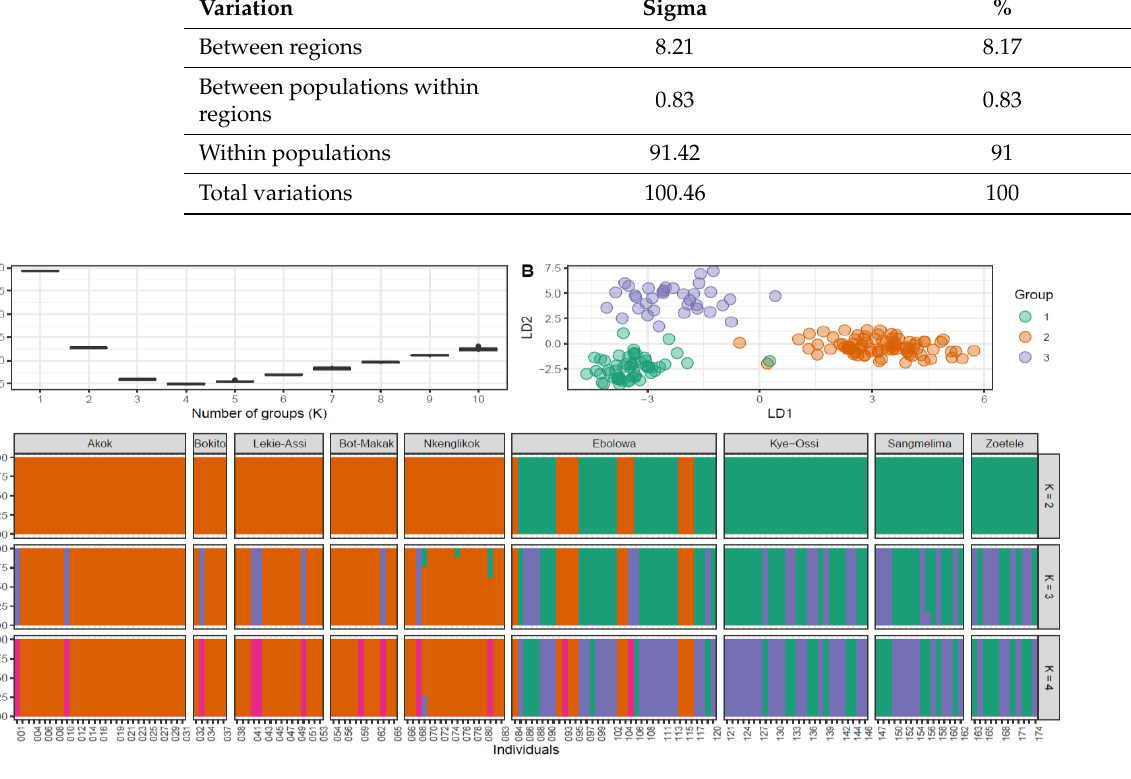
Figure 5. Discriminant analysis of principal components ( A ). Value of BIC vs. number of clusters ( B ). Scatterplot of analysed individuals assigned into three clusters ( C ). Barplot of analysed individuals for K = 2 – 4 showing the assignment probability of each individual into one of the inferred genetic clusters (Central region: Akok, Bokito, Lekiasi, Bot-Makak, Nkelikok; South region: Ebolowa, Kye- Ossi, Sangmelima, Zo é tel é ).